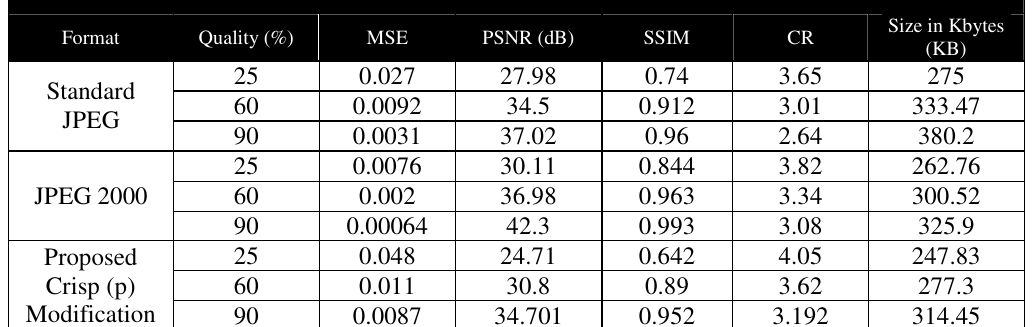
TABLE 4. COMPARISON OF THE PROPOSED MODEL WITH STANDARD JPEG AND JPEG 2000